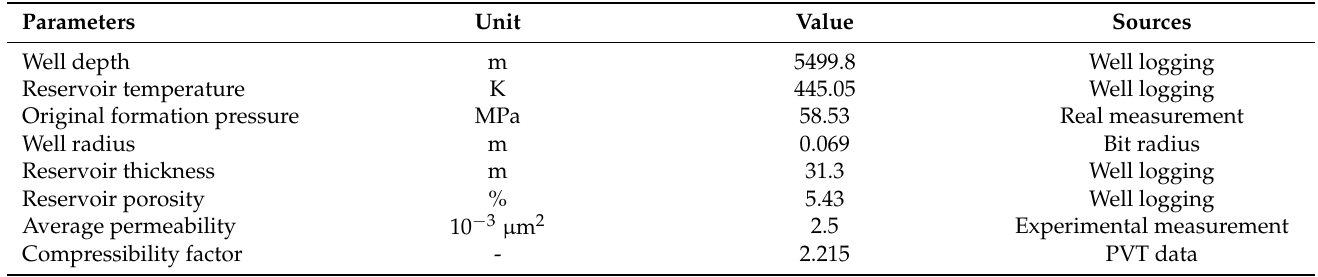
Table 2. The reservoir of this